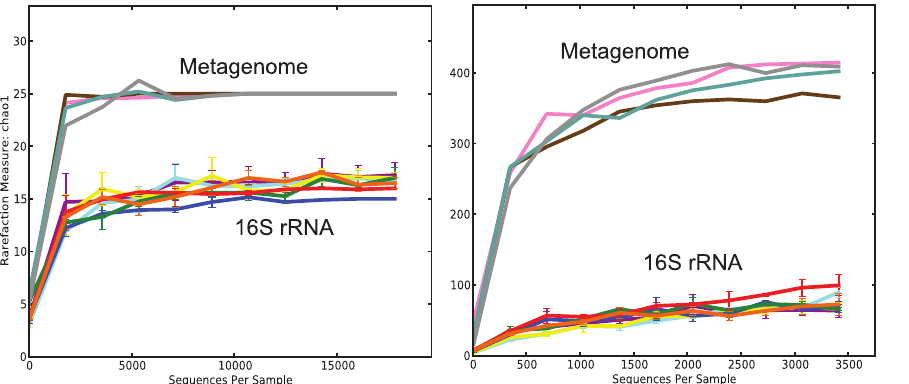
Figure 3. Sequence diversity of the samples used in this study . Chao1 diversity estimates of datasets based on phylum (A) and genus (B) level taxonomic classification are shown for all four metagenomic timepoints and seven selected 16S amplicon datasets.